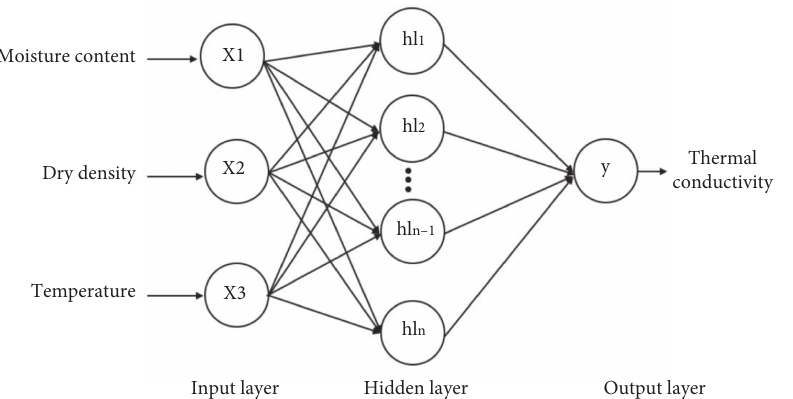
Figure 6: Schematic diagram of the structure of ANN